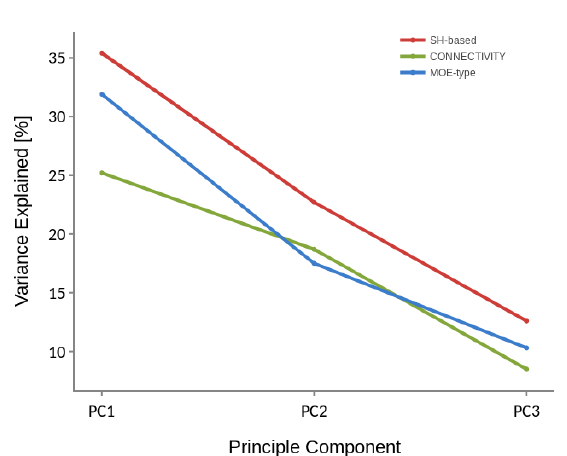
Figure 3. Three principal components ranked by the amount of variance they capture in P35372 dataset for Spherical Harmonics-based, MOE-type and Connectivity